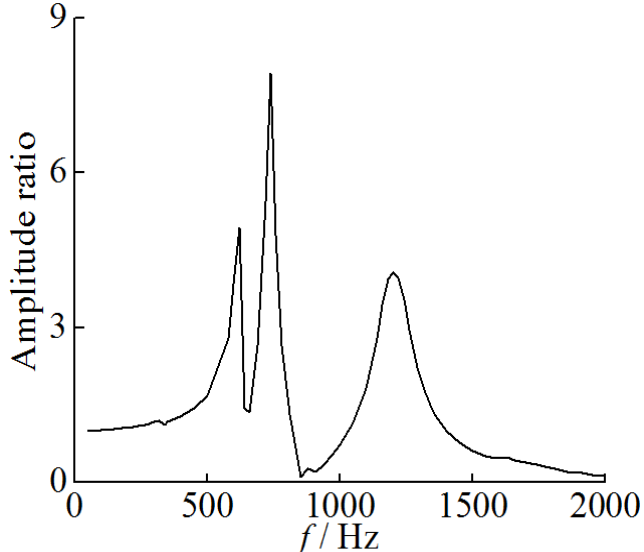
Figure 7. The calculation result of the amplitude-frequency characteristic.